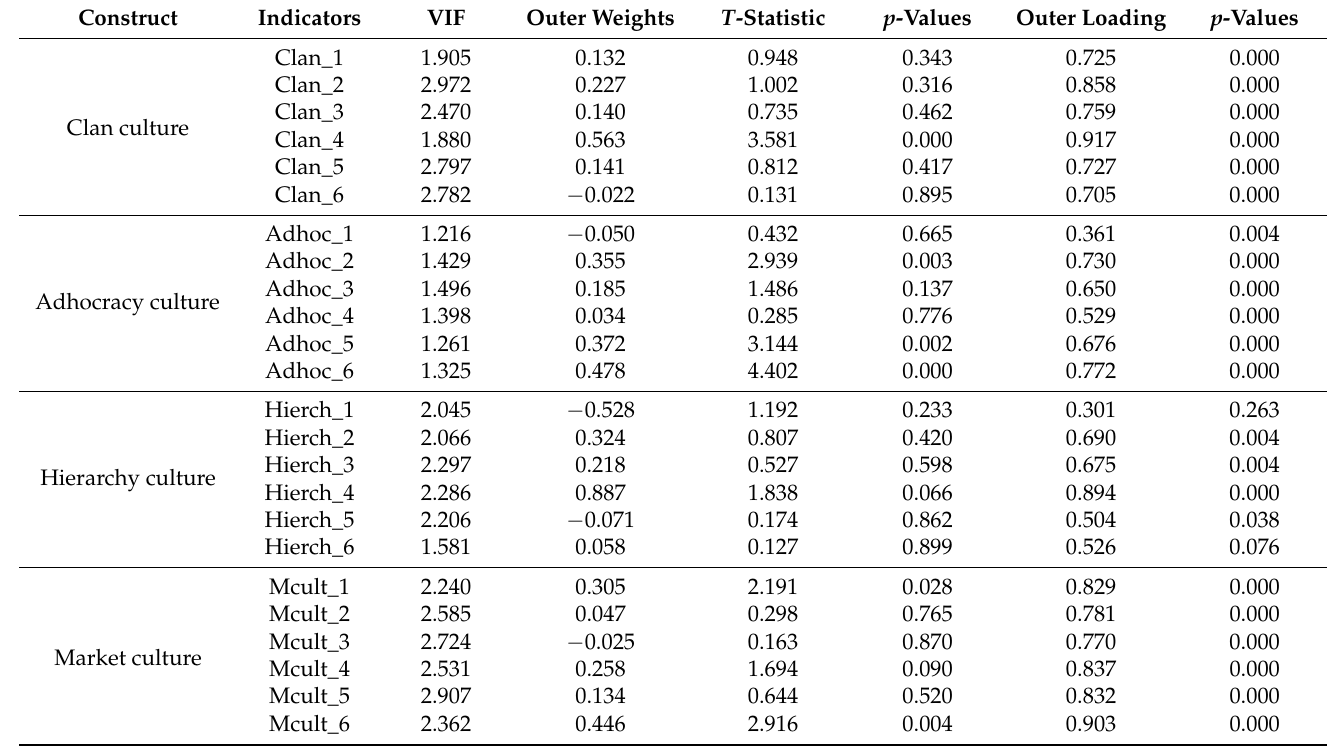
Table 3. Outer weights, outer loadings and VIF for formative